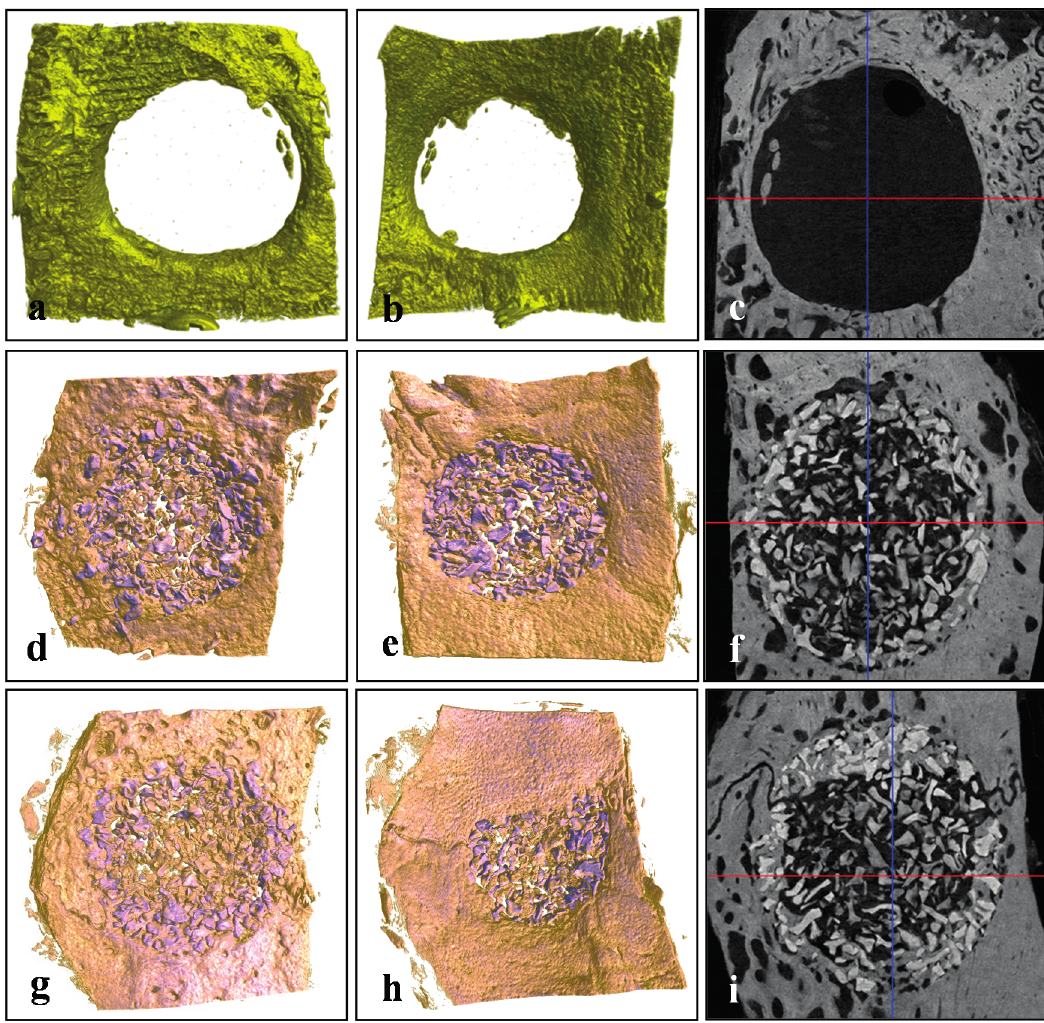
Figure 5. Representative μ CT images of each group at four weeks after surgery. ( a – c ) controls; ( d – f ) the Bio-Oss ® group; ( g – i ) the BMP-2/Bio-Oss ® group; ( a , d , g ) outer images of defect sites; ( b , e , h ) inner images of defect sites; ( c , f , i ) horizontally sectioned images of defect sites; remained Bio-Oss ® particles are purple